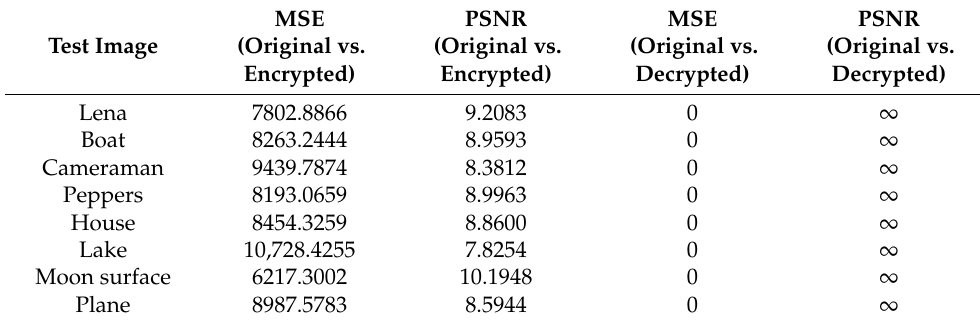
Table 4. Test results of the encryption and decryption performances by different metrics.